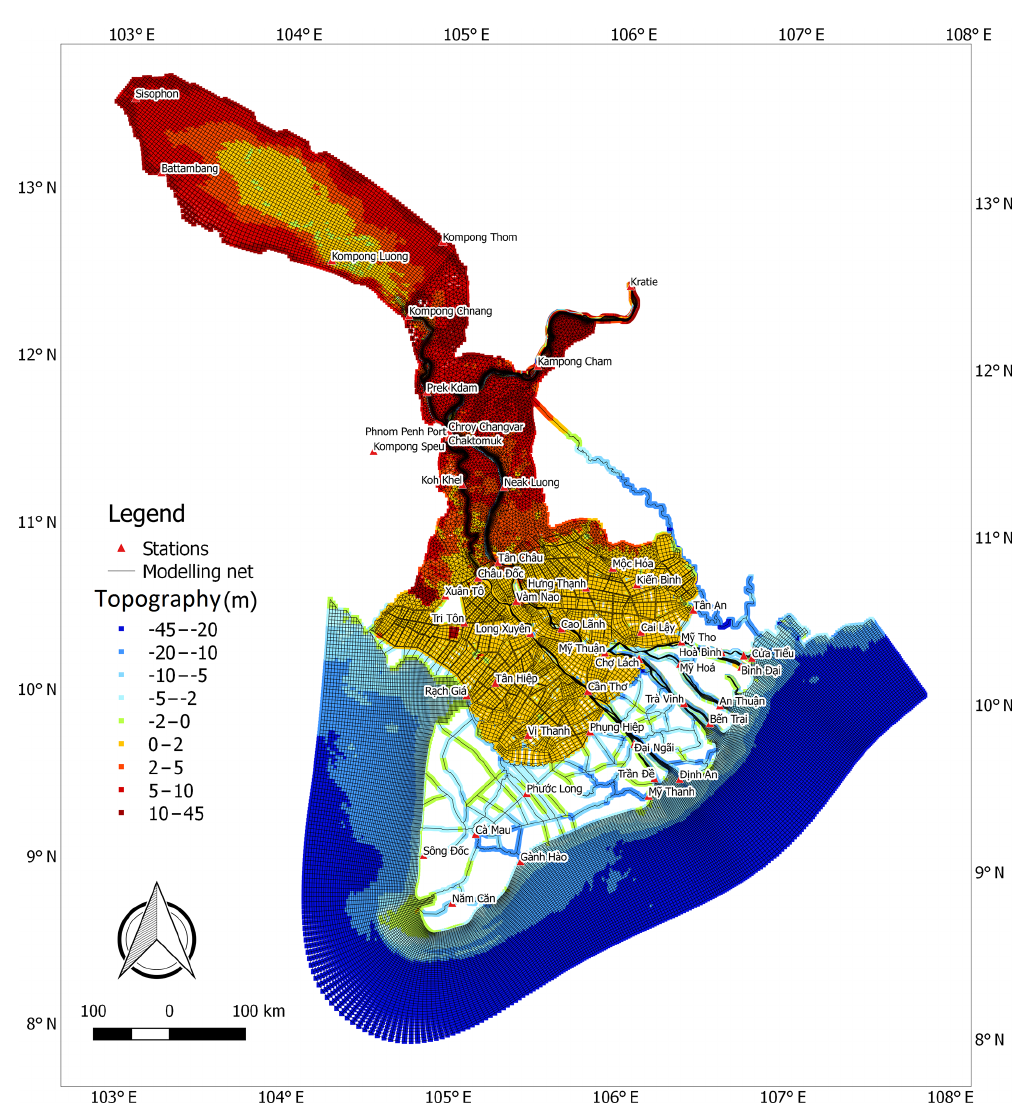
Figure 6. Mekong Delta modelling grid and river interpolated topography from 1-D ISIS cross-section data and the shelf topography of the Mekong